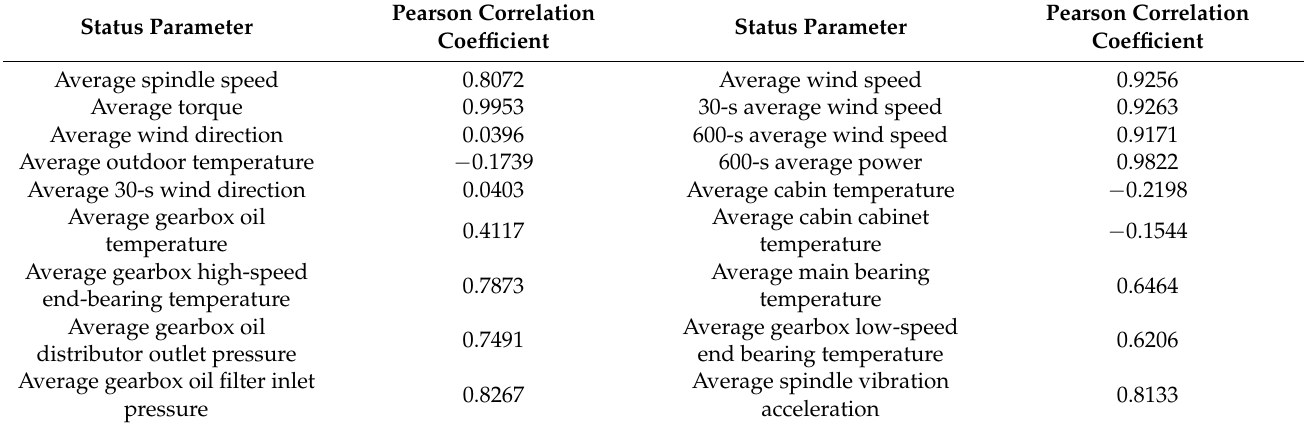
Table 2. Pearson correlation coefficients between transmission system status parameters and the average 30-s